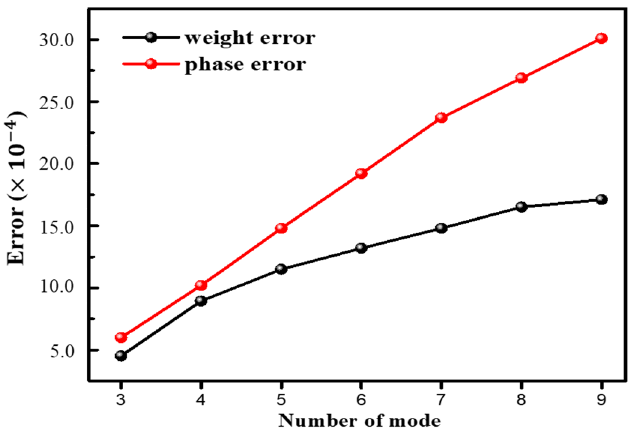
Figure 4. The relationship between mode error and the change of mode number.